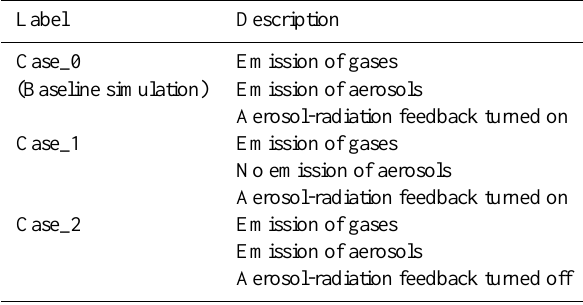
Table 4. Description of WRF-Chem simulations.